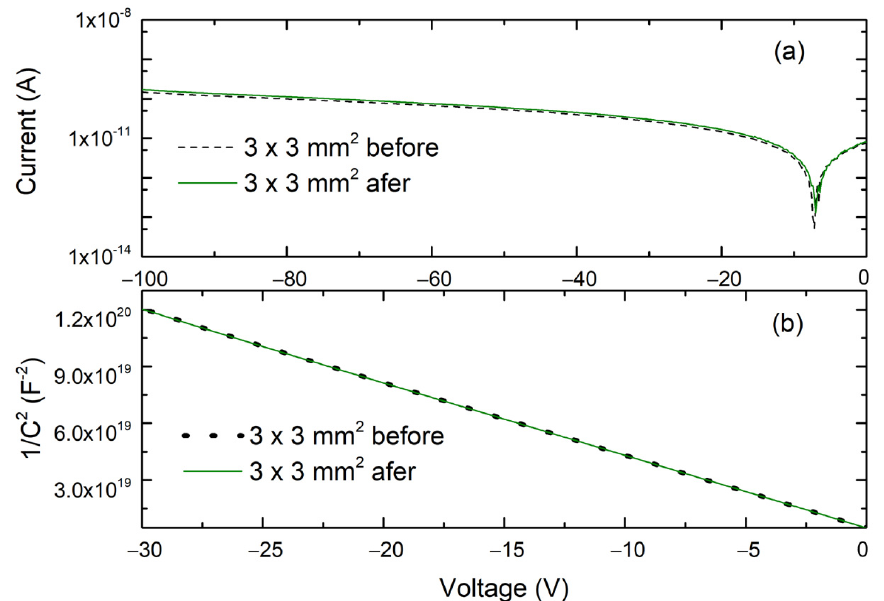
Figure 1. ( a ) I–V characteristics and ( b ) 1/C 2 –V characteristics for the 4H-SiC SBD, before and after radiation test.